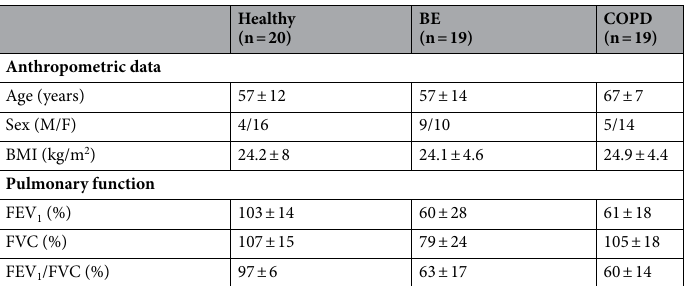
Table 1. Patient characterization. M: male; F: female; BMI: body mass index. FEV 1 (%): forced expiratory volume in the first second. FVC: forced vital capacity; FEV 1 /FVC (%): Tiffeneau index. Healthy: no pulmonary disease; BE: bronchiectasis. COPD: chronic obstructive pulmonary disease.